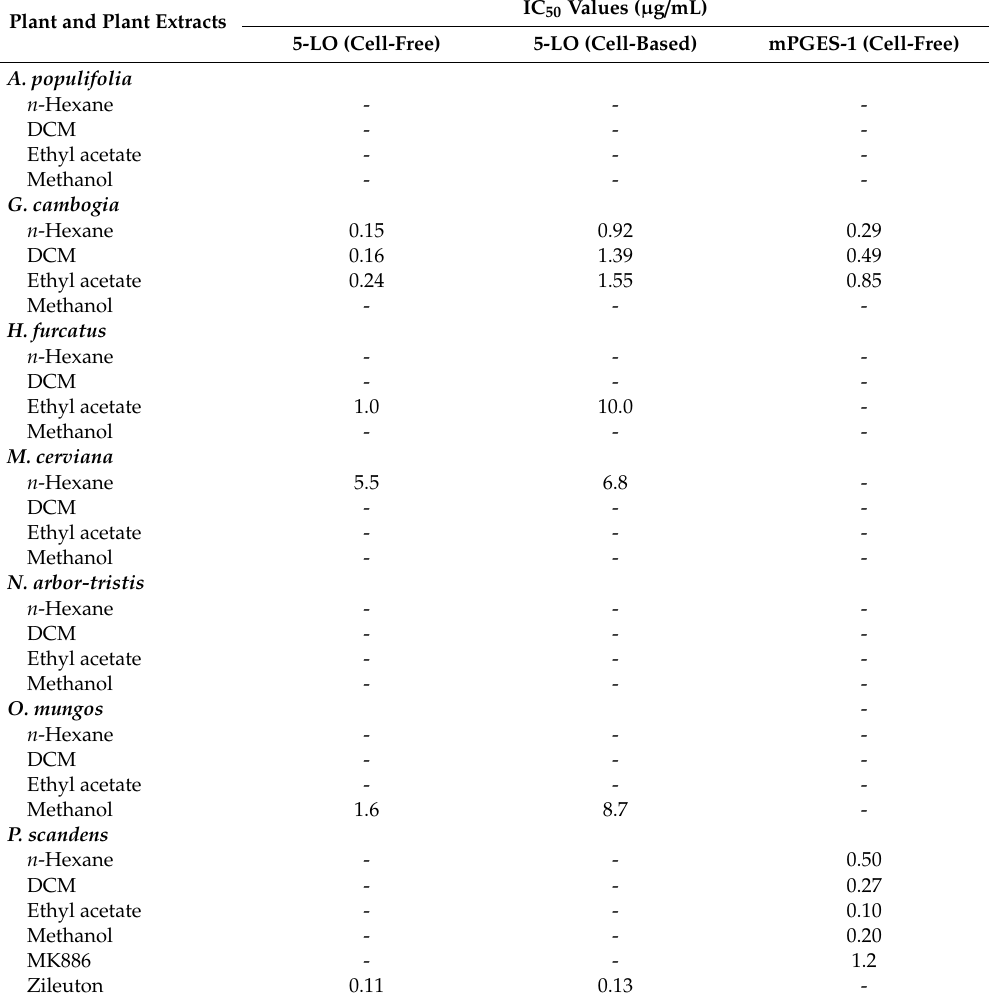
Table 1. IC 50 values of the investigated plant extracts for interference with 5-LO (cell-free and cell-based) and mPGES-1 (cell-free). MK886 and zileuton were used as reference drugs against mPGES-1 and 5-LO, respectively. For extracts that caused less than 50% inhibition at 10 µ g / mL, IC 50 values were not determined and are indicated as “-”. Data are given as means, n =